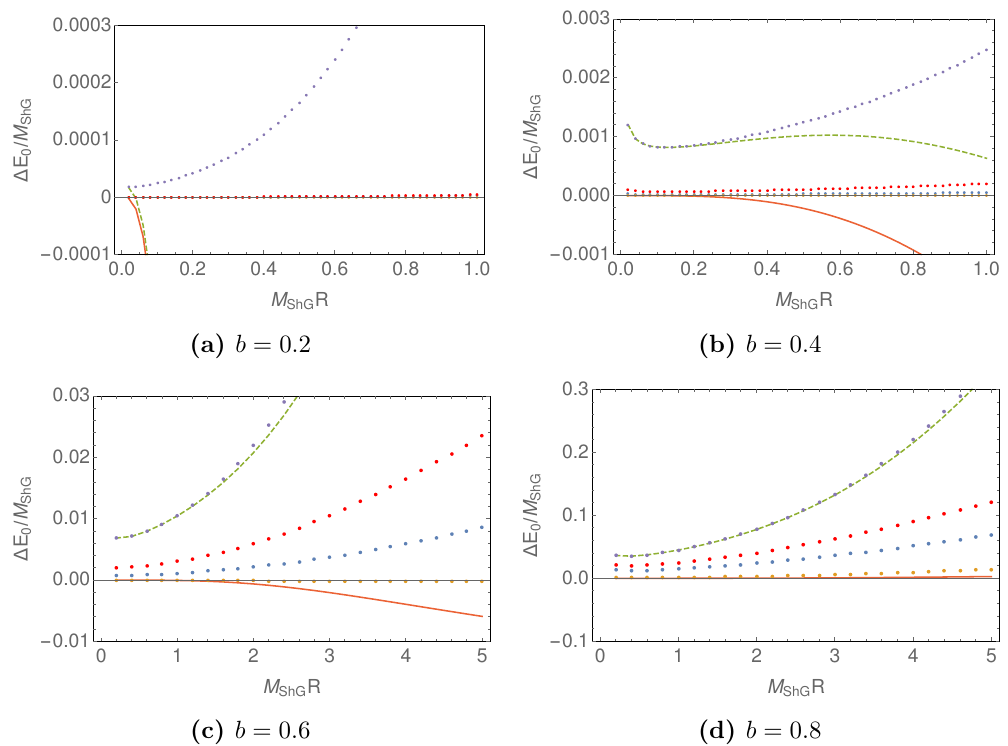
Figure 17. Comparison of the six different approaches available to estimate the UV behavior of the ground state energy at four different values of b . All data is presented with the exact TBA values subtracted. Blue dots: Raw ( N c = 12 ) TSM data; orange dots: extrapolated TSM data; purple dots: diagonalization of H ZM ; dashed green curve: semi-classical reflection quantization; continuous red curve: Liouville reflection quantization; and red dots: diagonalization of effective zero mode Hamiltonian, H eff ZM